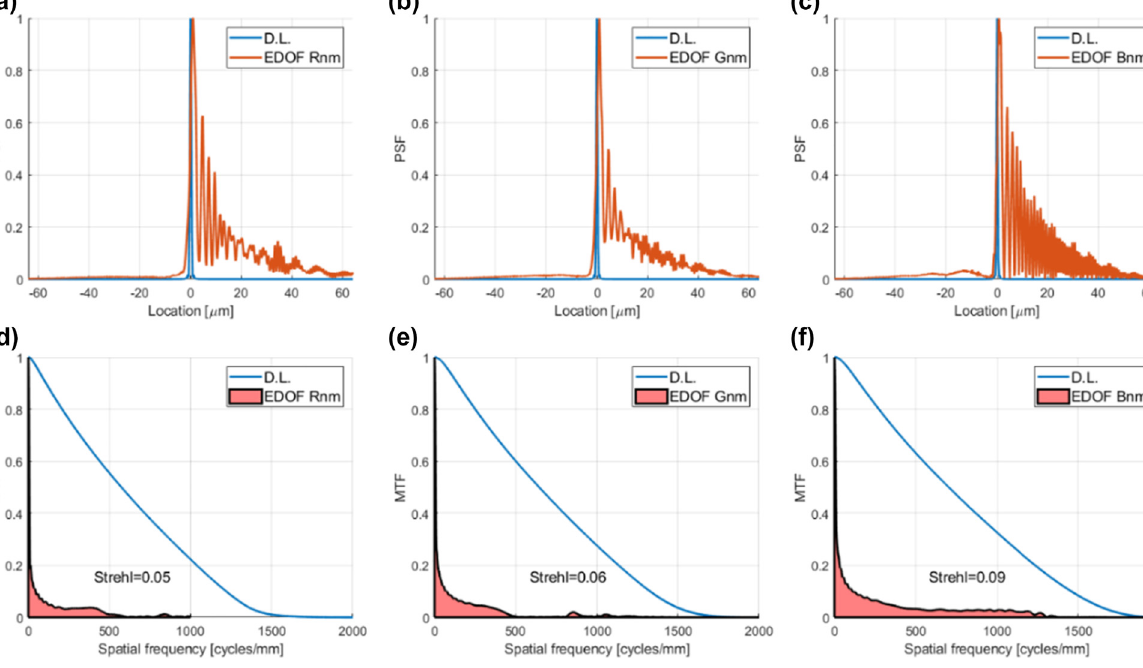
Figure 8: PSFs and MTFs of EDOF lens over RGB spectral ranges, defined according to spectral sensitivity of Thorlabs DCC1645C color camera. (a) R PSF cross section (b) G PSF cross section (c) B PSF cross section (d) R MTF (e) G MTF (f) B